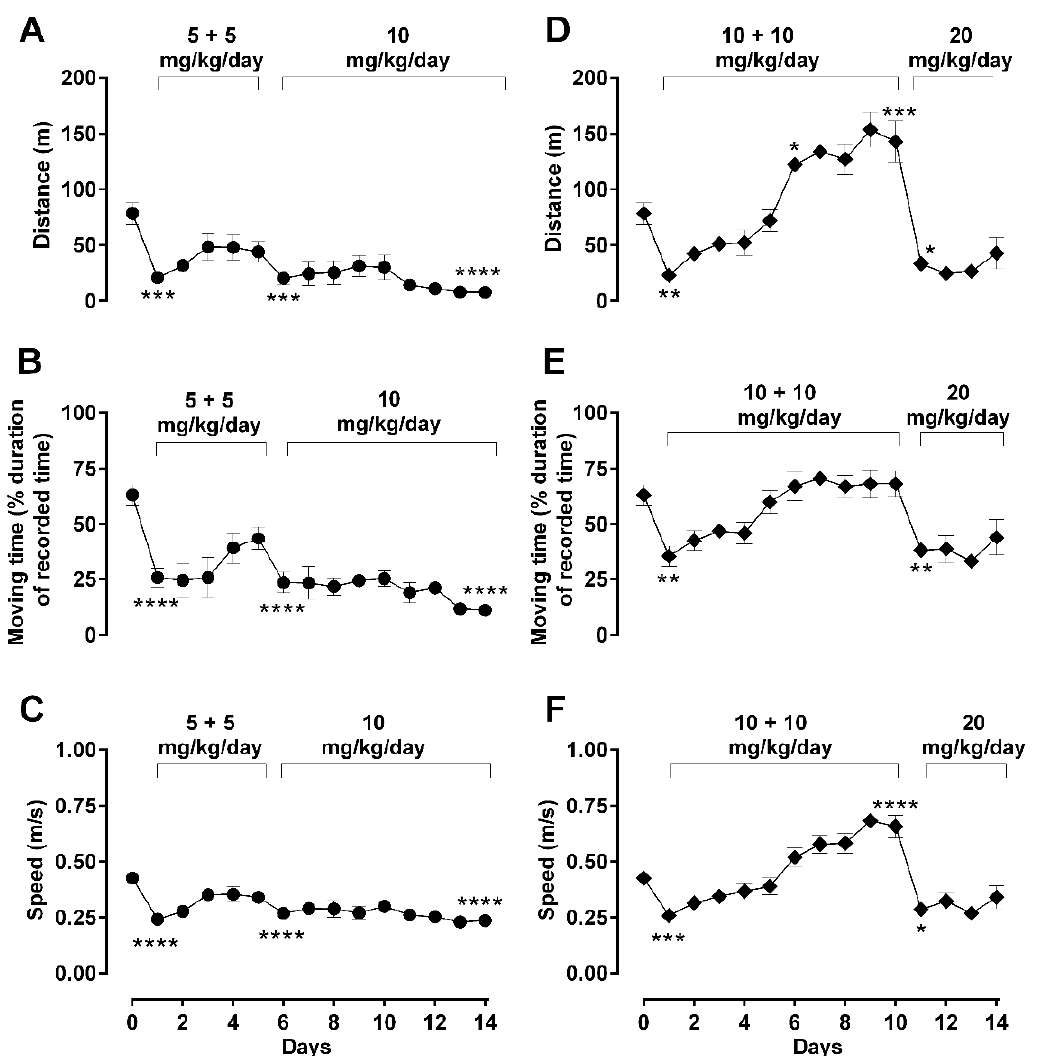
Figure 3. Effect of dosing regimen changes on basic locomotor activity during long-term morphine administration. Locomotor parameters were recorded daily in an open-field arena 30 min after daily subcutaneous injections of morphine in male Sprague–Dawley rats, during a 5 min recording period. Motor behavior of treated animals was assessed by quantification of distance travelled ( A , D ), moving duration ( B , E ), or average speed ( C , F ). Two morphine regimens were respectively used in two different groups of animals: 5 (b.i.d.) → 10 mg/kg ( A – C ) and 10 (b.i.d.) → 20 mg/kg ( D – F ) over a total period 14 days, as described in Methods . Values are presented as mean ± SEM ( n = 6 animals per group). Error bars are sometimes too small to be visible. Statistically significant ( p < 0.05) differences compared against day 0 are shown as * p < 0.05, ** p < 0.01, *** p < 0.001, and **** p < 0.0001 and were calculated using one-way ANOVA with Dunnett’s multiple comparisons test. The behavioral differences between these two dosing groups are shown as the differences in their area under the curves (AUC) in Table 2, which indicates that differences were observed in all three behavioral parameters.